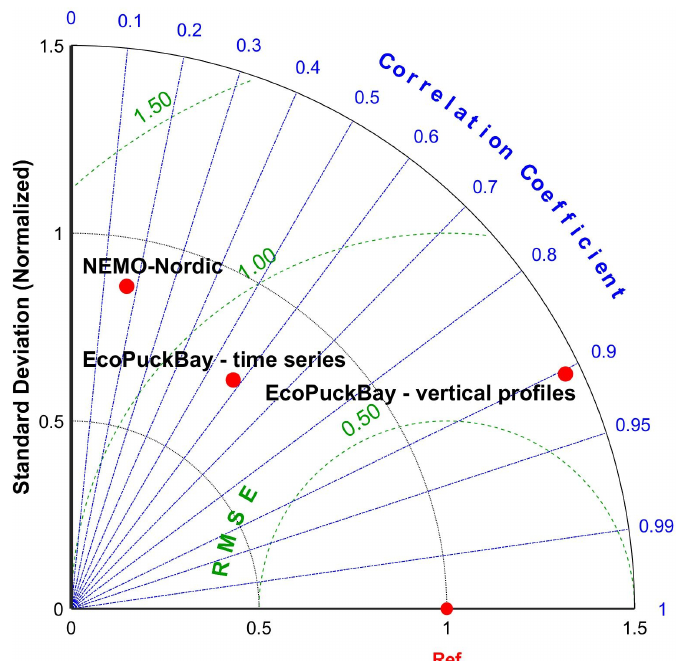
Figure 5. Taylor diagram for salinity.